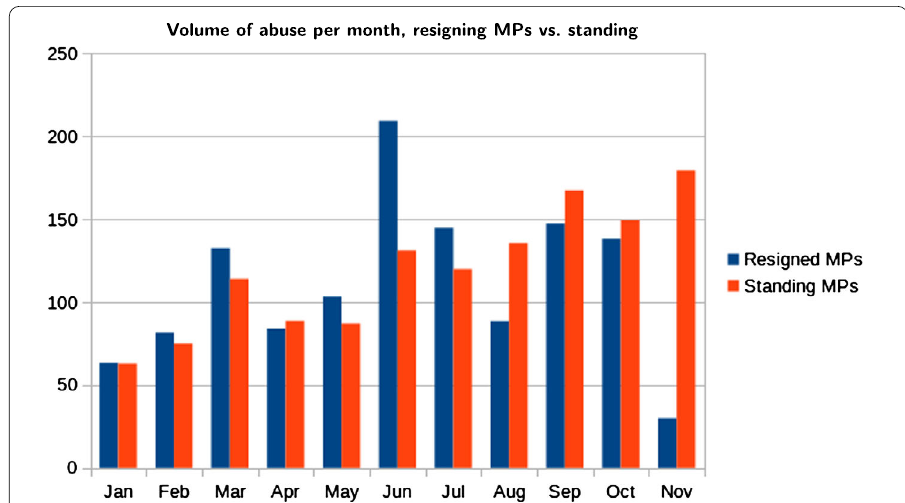
Figure 11 Volume of abuse per month, resigning MPs vs. standing. Macro-averaged abuse per month per individual for those MPs who chose to stand again vs those who chose not to